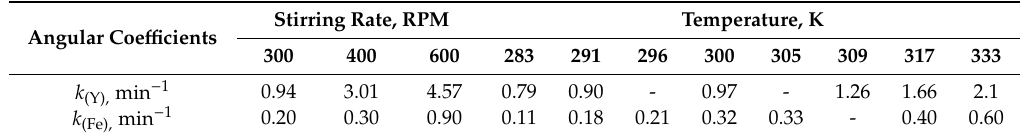
Table 3. Thevaluesoftheangularcoefficients—rateconstantsoftheyttriumandiron(III)extractionprocess. Angular Coe ffi cients